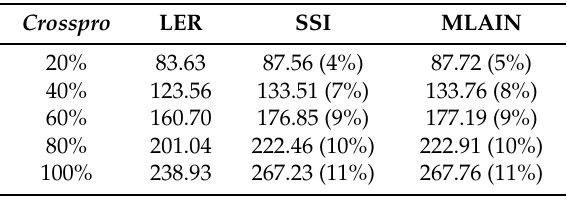
Table 2. Average tuning time for changing Crosspro values.